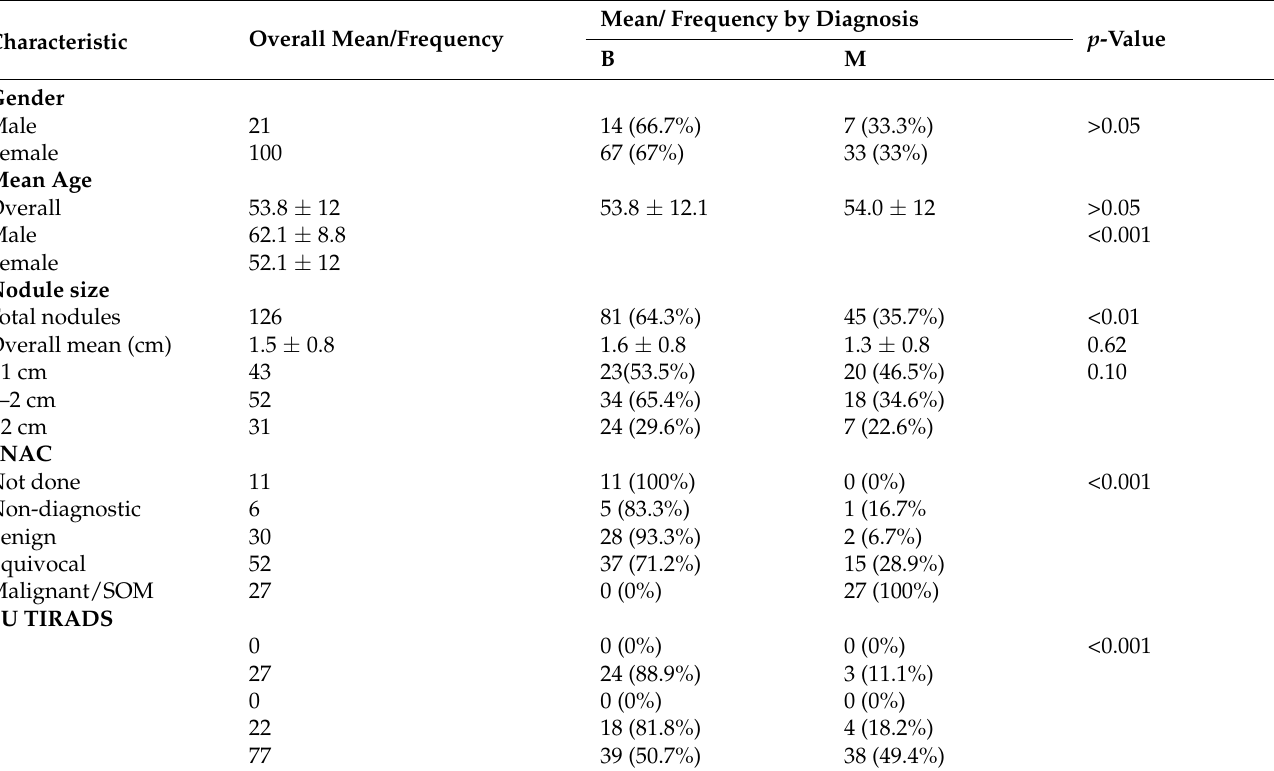
Table 1. Demographic data and the distribution of nodules into different